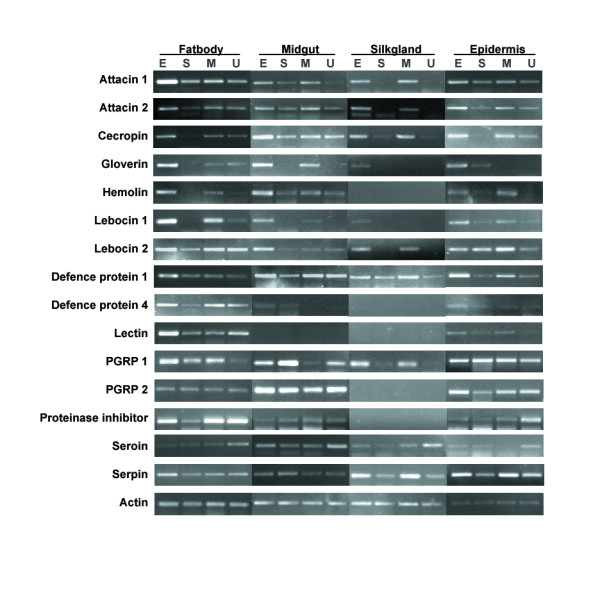
RT-PCR profiles of 15 putative immune genes from 4 differentially challenged tissues of 5th instar larvae. E- E. coli challenged, M- M. luteus challenged, S- saline-injected, U- unchallenged. Actin was used as an endogenous control. The GenBank accession numbers of the 15 genes are provided as additional data (see Additional data file 5).